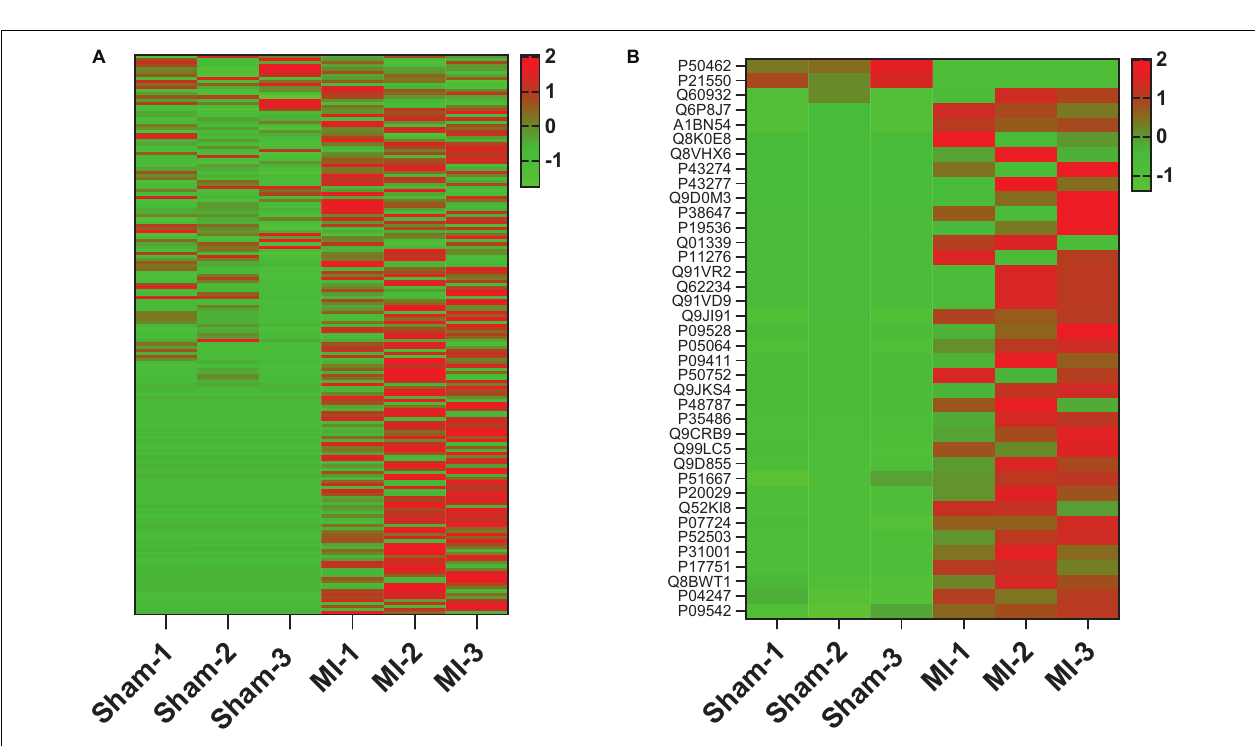
FIGURE 5 | MI increases the abundance of MetRS ∗ MSC exosomal proteins in the heart. MetRS ∗ MSC-Exos were injected into the tail vein of mice 24 h after MI induction or Sham surgery ( n = 3 per group). Animals were euthanized 24 h after exosome administration, and protein extracts were prepared from the left ventricle; then, the ANL-labeled MetRS ∗ MSC exosomal proteins were isolated via click-catalyzed alkyne-agarose capture and identified via LC-MS. (A) Heat map of all identified MetRS ∗ MSC exosomal proteins. (B) Heat map of MetRS ∗ MSC exosomal proteins that were differentially expressed in MI and Sham hearts.